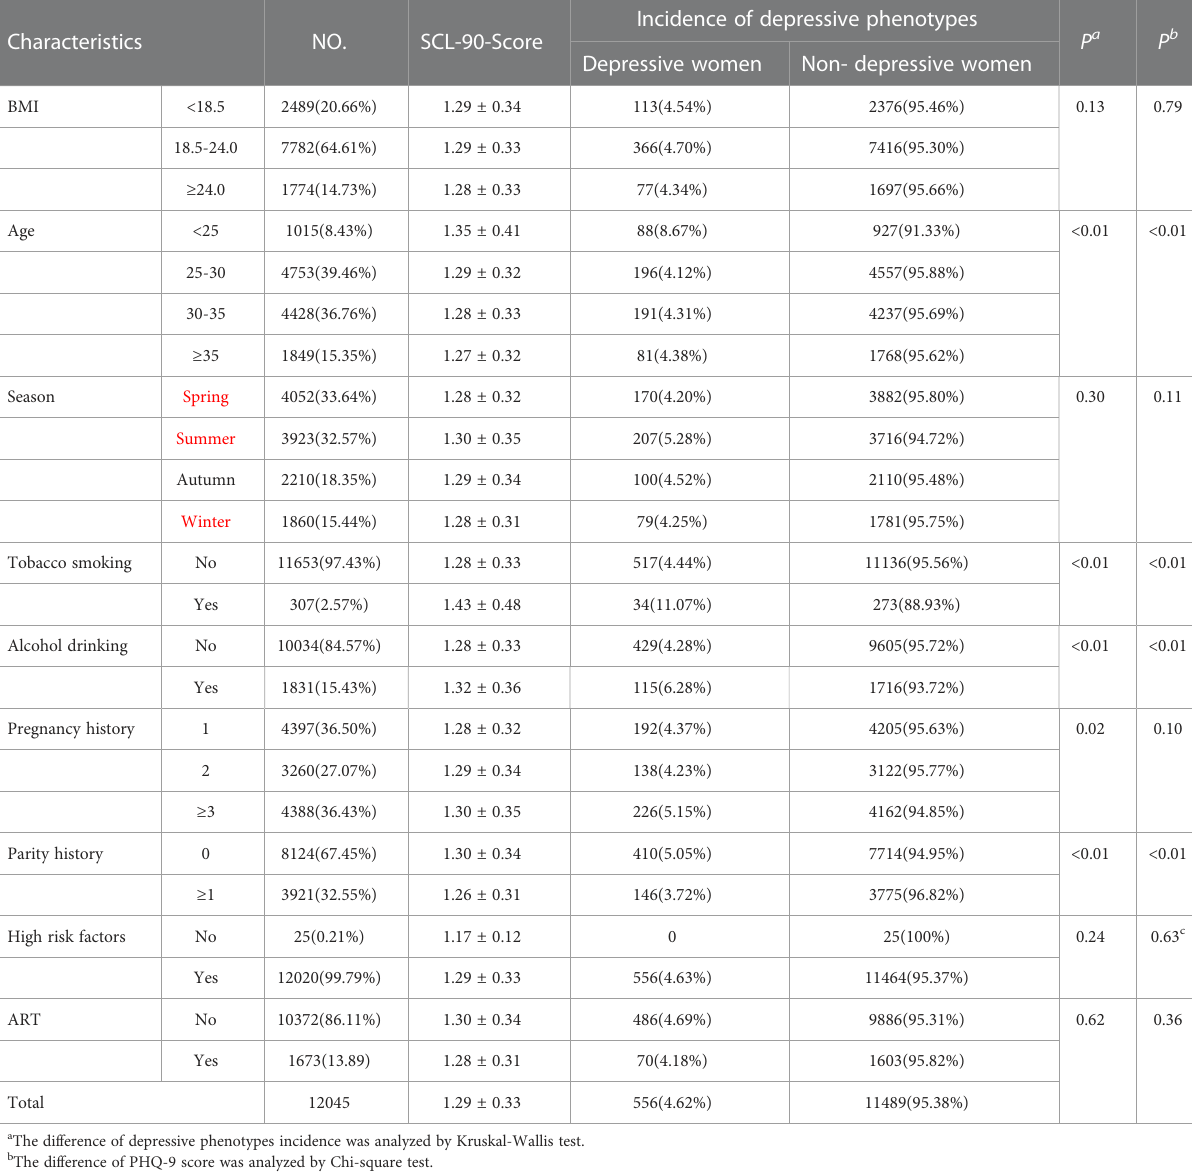
TABLE 2 The distribution of depressive phenotypes estimated by the SCL-90 and the score of the scale.